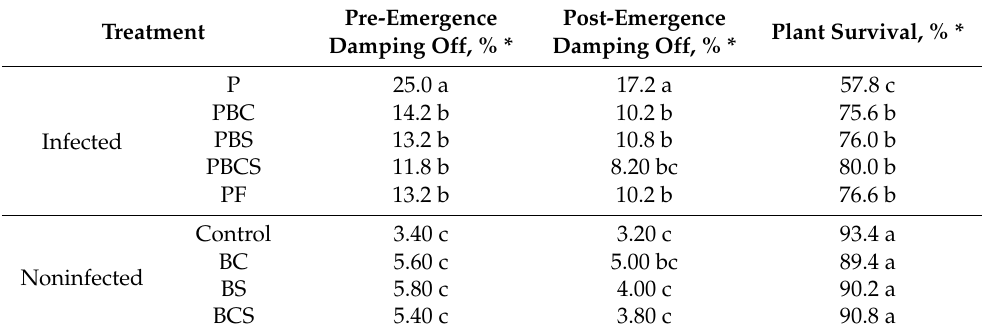
Table 4. Effect of Achromobacter sp. F23KW on Rhizoctonia root rot development on fenugreek seedlings under greenhouse